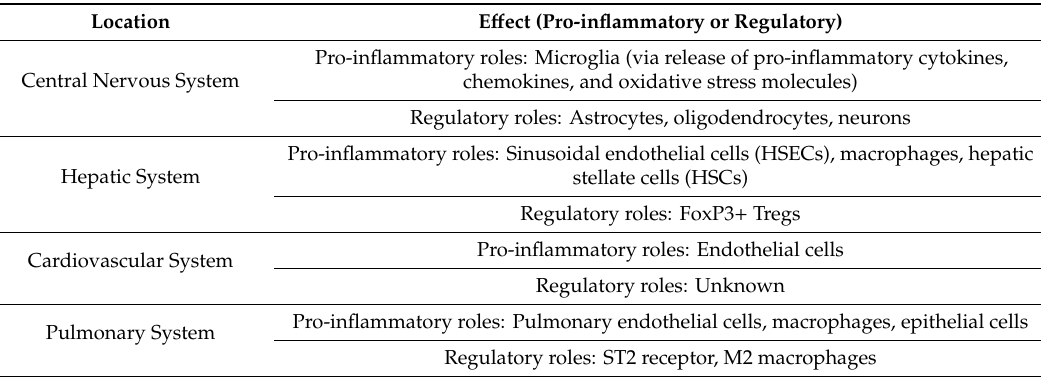
Table 4. IL-33 summary table (mice).